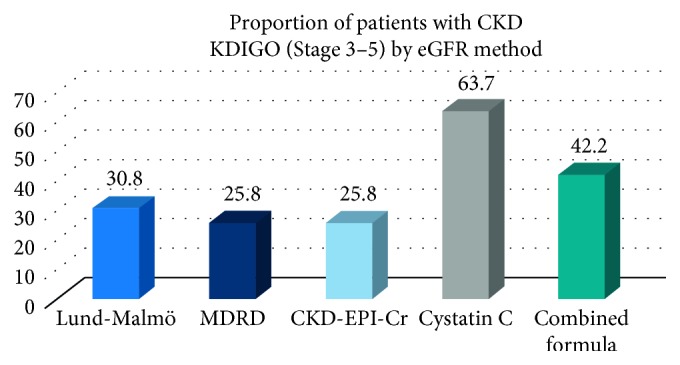
Categorisation of patients by CKD group (stage 3–5) at follow-up according to the method of GFR estimation, in 201 patients where both variables were measured.